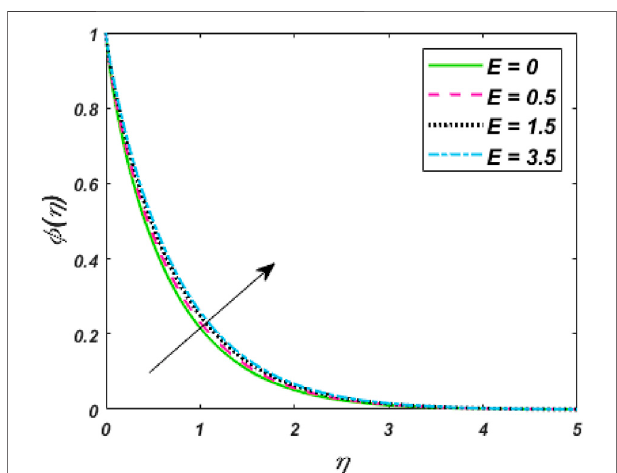
FIGURE 12 | E against ϕ ( η ) .